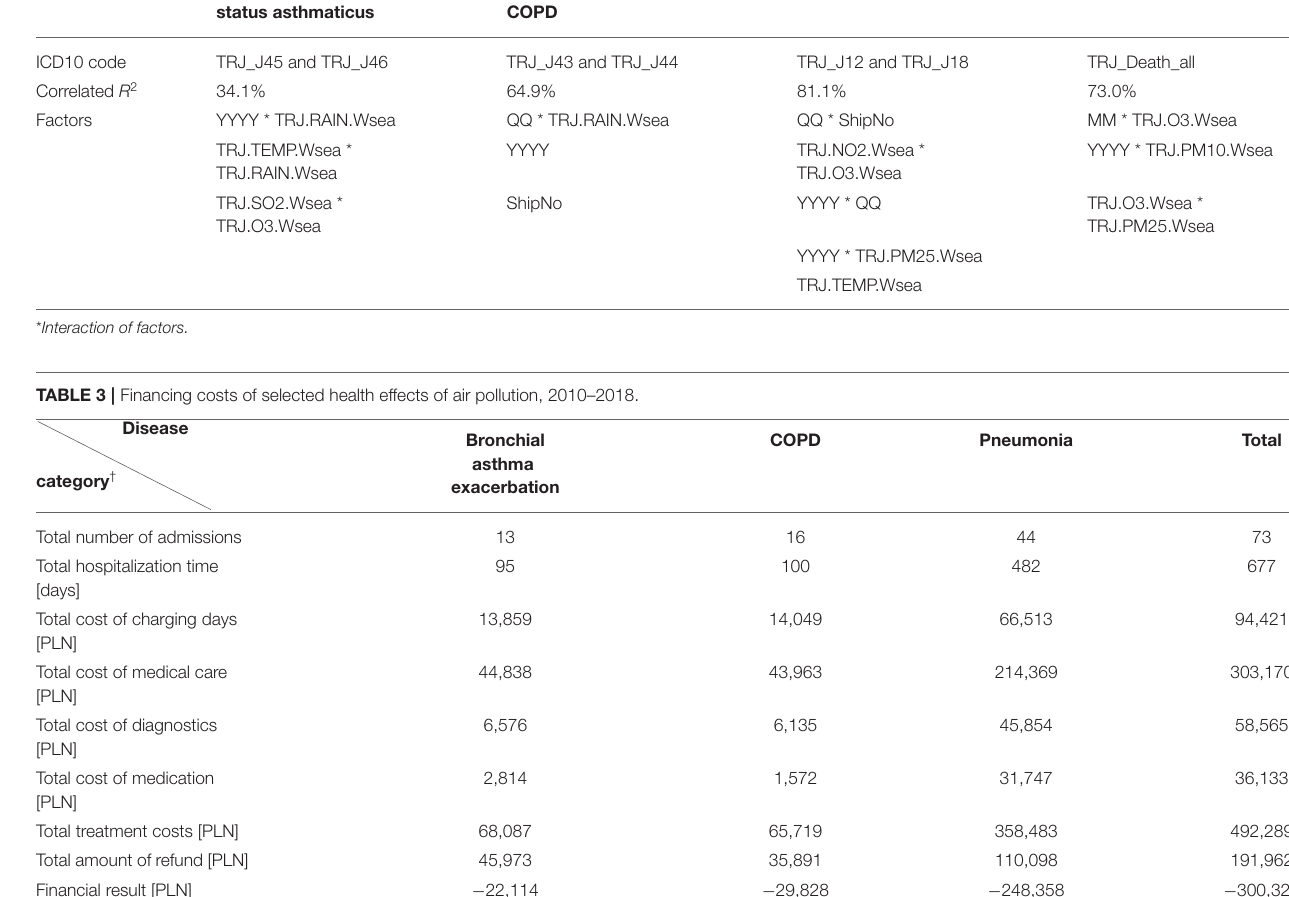
TABLE 2 | GRM that consider only maritime emissions in terms of air pollution and meteorological factors of the selected diseases and disease-related deaths in the Tri-City, 2010–2018. Disease